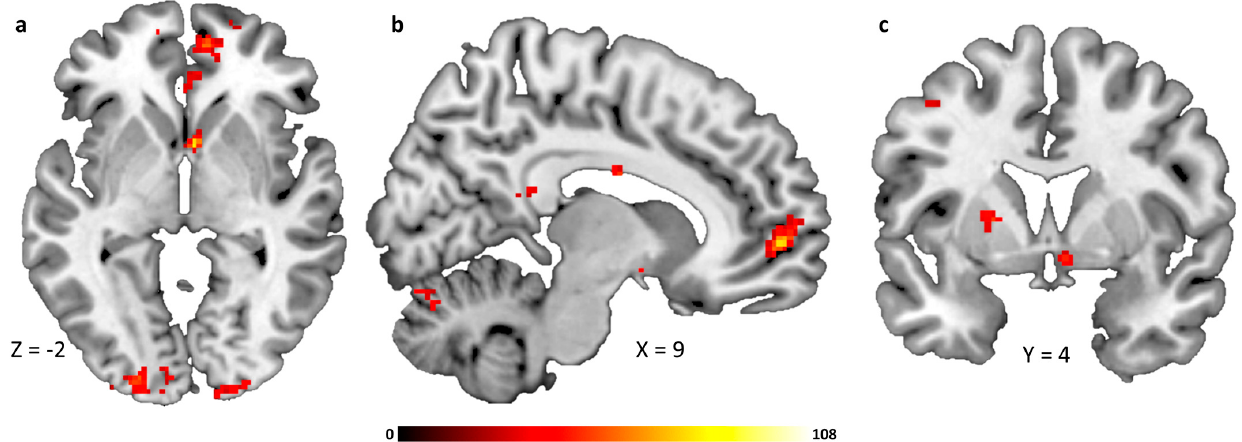
Figure 4. Brain regions showing glycemia-dependent functional connectivity with the hypothalamus, ( a ) medial prefrontal/orbitofrontal cortex and caudate head, ( b ) medial prefrontal/orbitofrontal cortex, ( c ) putamen. All whole-brain results are reported at a threshold of p < 0.05 corrected for multiple comparisons using FWE correction for small volumes and a cluster-defining threshold of k > 30 voxel minimal cluster size. Color bar indicates F